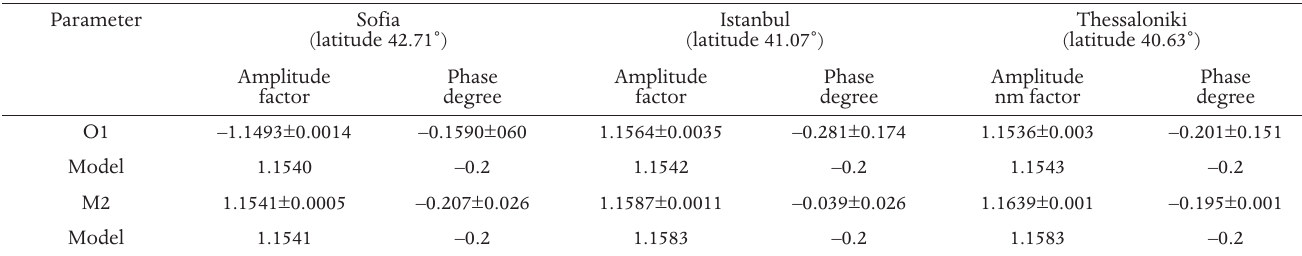
Table 2. Ocean corrected parameters of O1 and M2 in the three neighboring stations.